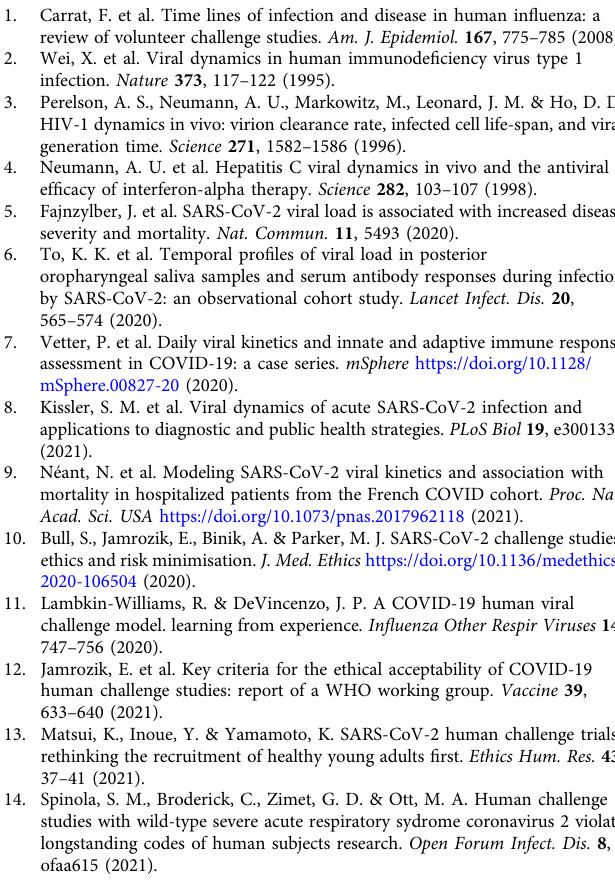
Fig. 9 Evaluation of CD8 + T-cell targeting of SARS-CoV-2 in blood samples from participants who did not become positive for SARS-CoV-2 RNA by RT-qPCR between March 23, 2020 and April 1, 2021 (date of blood collection). IFN- γ ELISpot was performed on polyclonally expanded CD8 + T cells using peptides spanning spike, nucleocapsid, matrix, and envelope proteins that were combined in pools of 16 or fewer. Spike was contained in 12 pools (S1 to S12), nucleocapsid in four pools (N1 to N4), matrix in two pools (M1 to M2), and envelope in one pool (E2). Panels A – D present frequencies of responses from individual participants, while panel E provides summary data as percentages of persons responding against each pool. Each panel consists of two sub-panels, with the left sub-panel showing responses against individual peptides, while the right sub-panel shows the total responses for each peptide pool. Negative values for the responses were replaced by zeros in the left sub-panels. The total values for S, N, and M do not necessarily equal the sums of the pools because the sums were calculated including negative values after background subtraction. Horizontal dotted lines indicate the cutoff for positivity based on the following criteria: at least 50 SFC/10 6 CD8 + T Lymphocytes and >mean and two standard deviations of negative control wells (no peptide). A Circles, subject 17; B squares, subject 18; C triangles, subject 24; D diamonds, subject